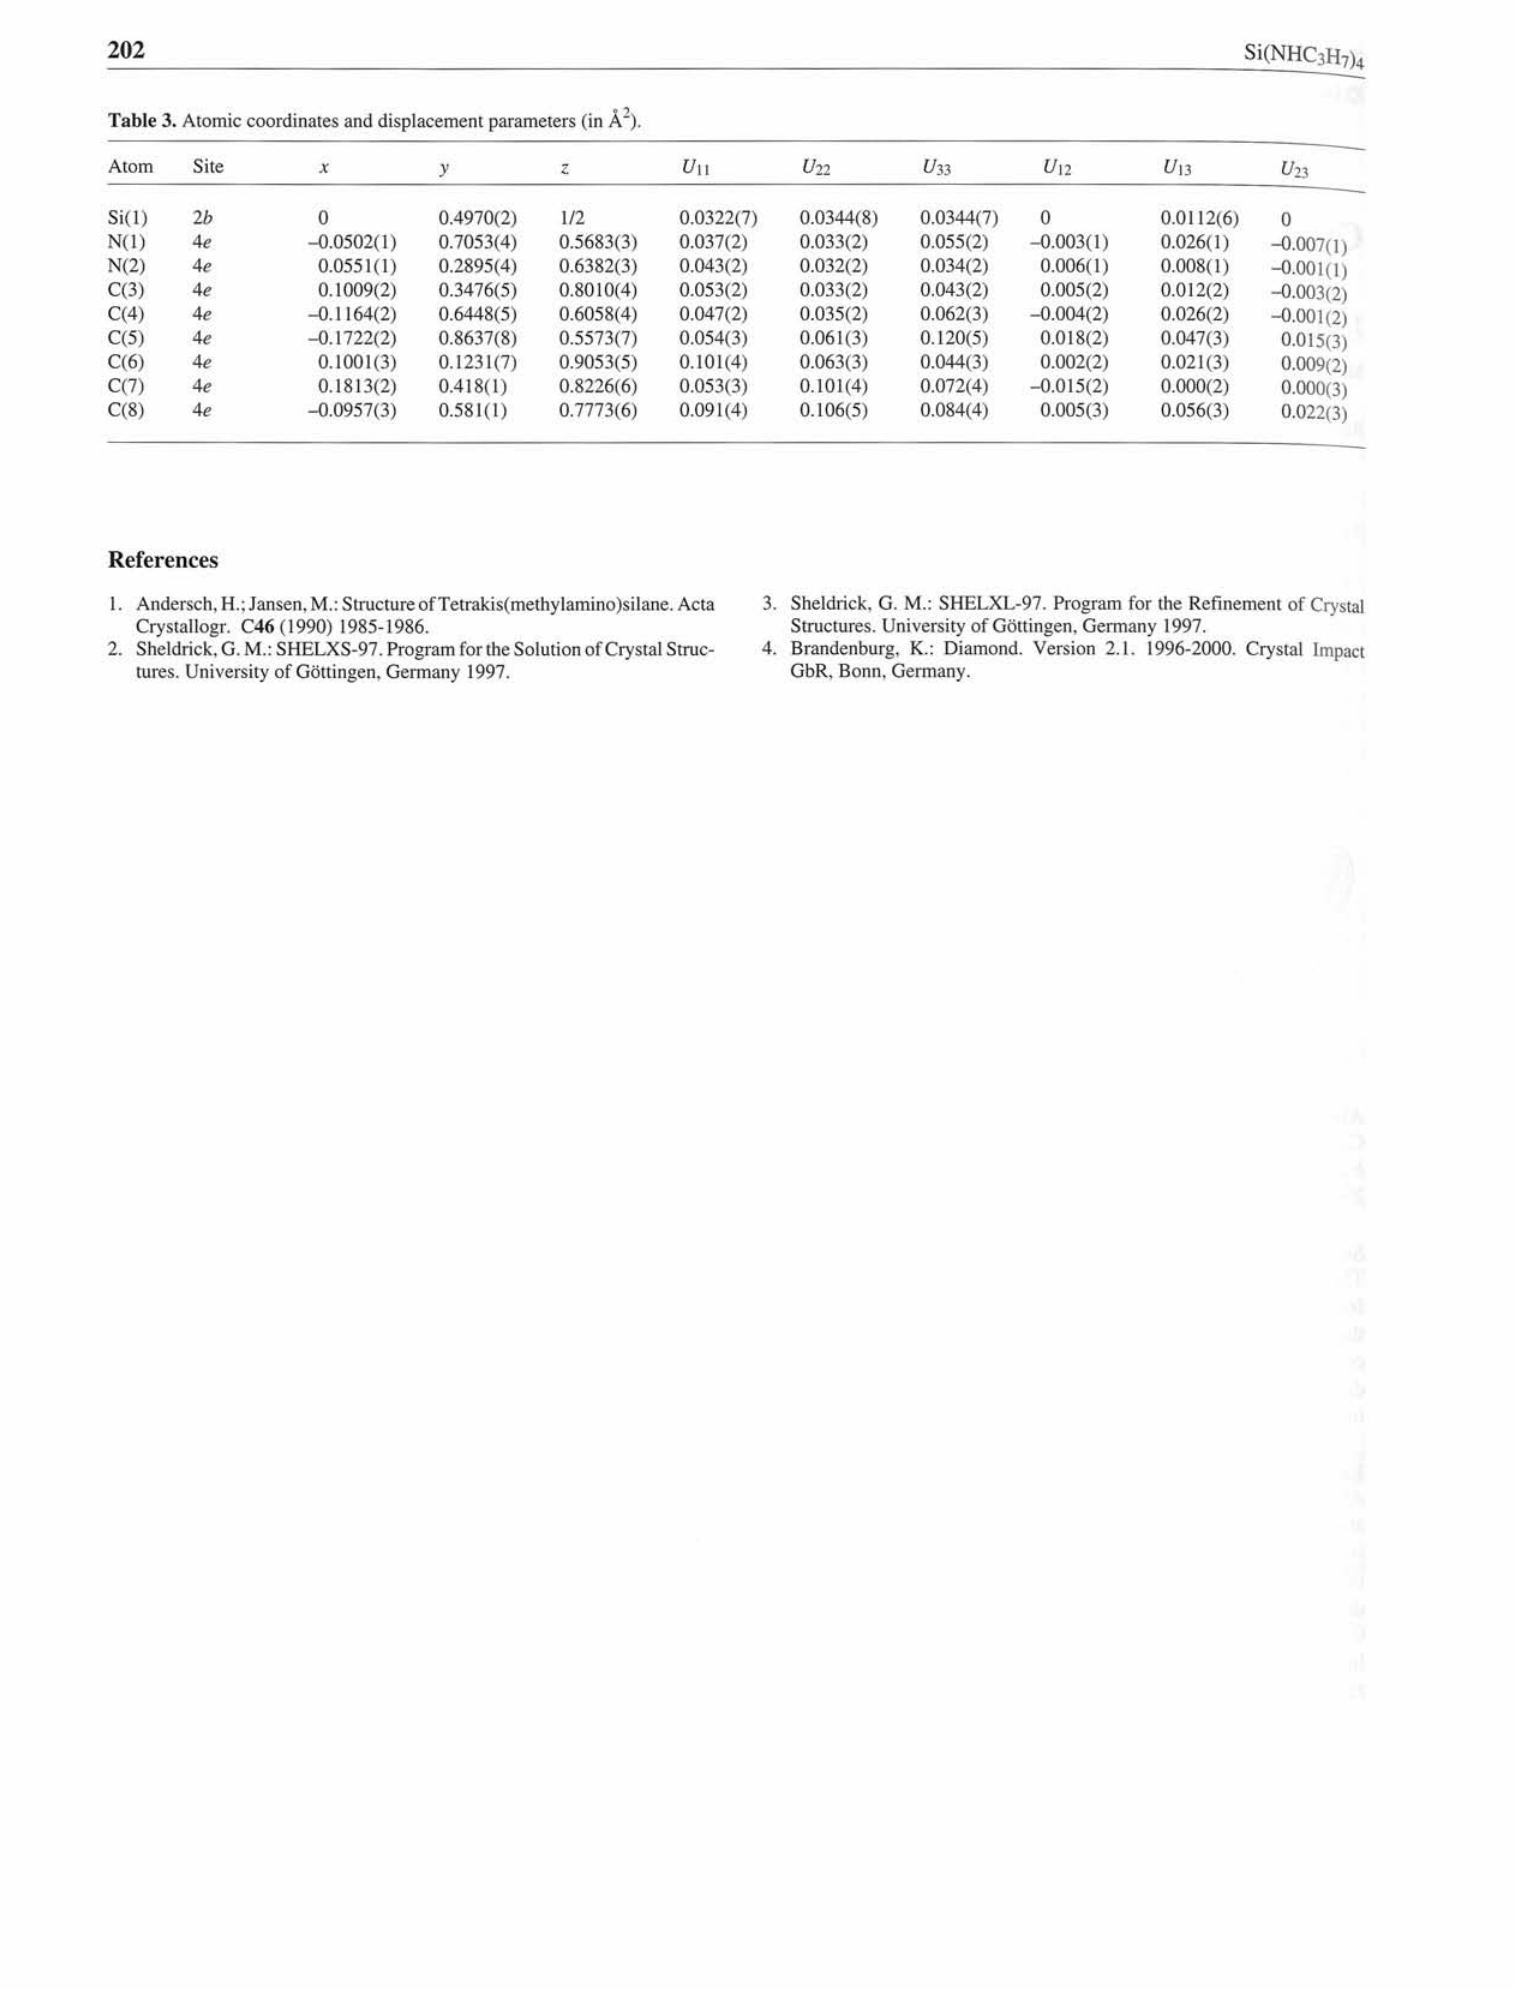
Table 3. Atomic coordinates and displacement parameters (in Â 2